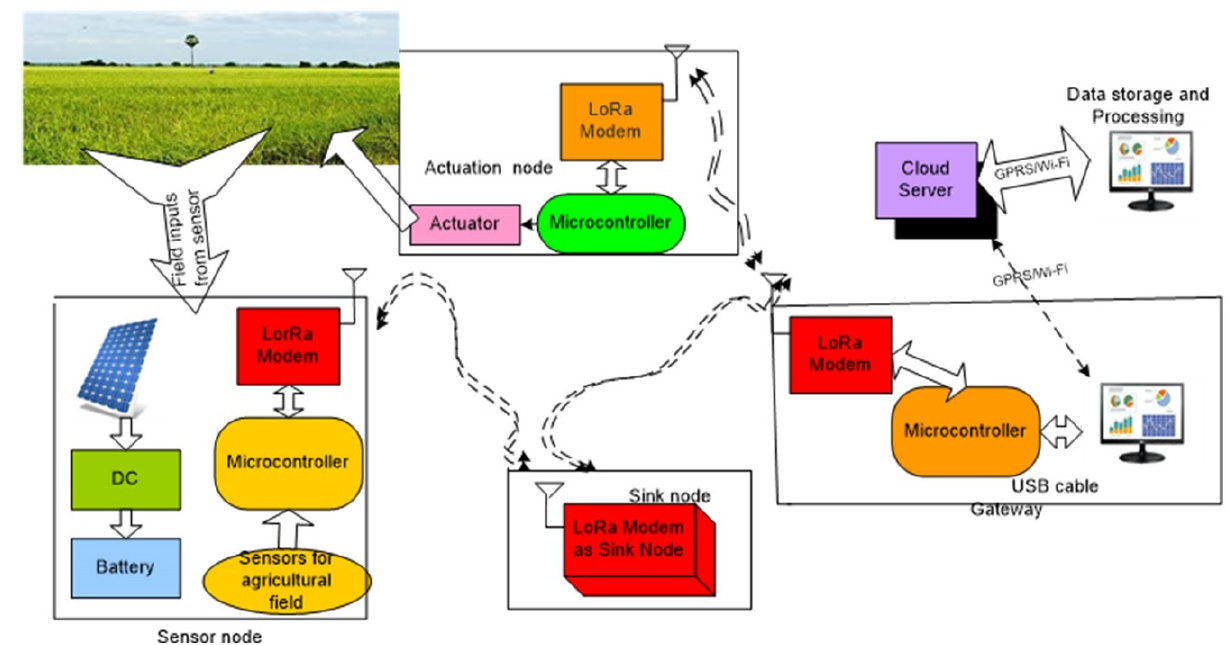
Figure 6. Block diagram of IoT-based farm automation using a solar panel.